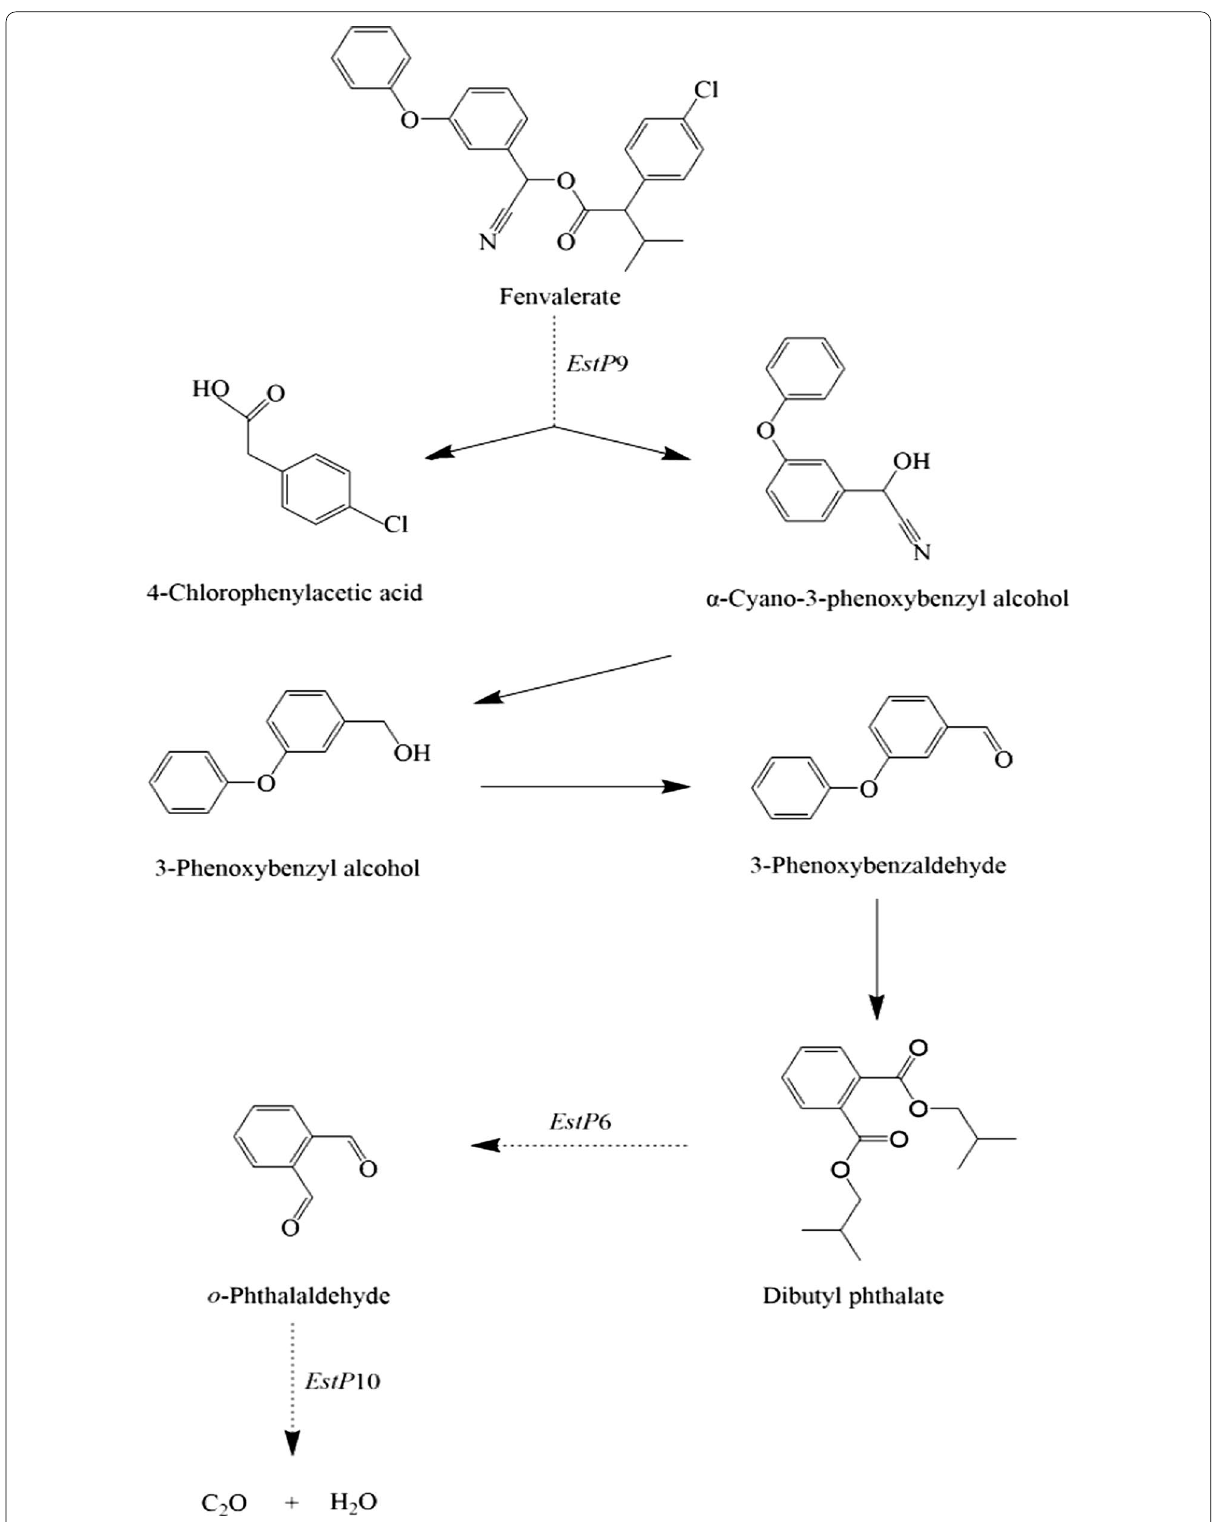
Fig. 7 Proposed pathway of fenvalerate degradation by C. freundii